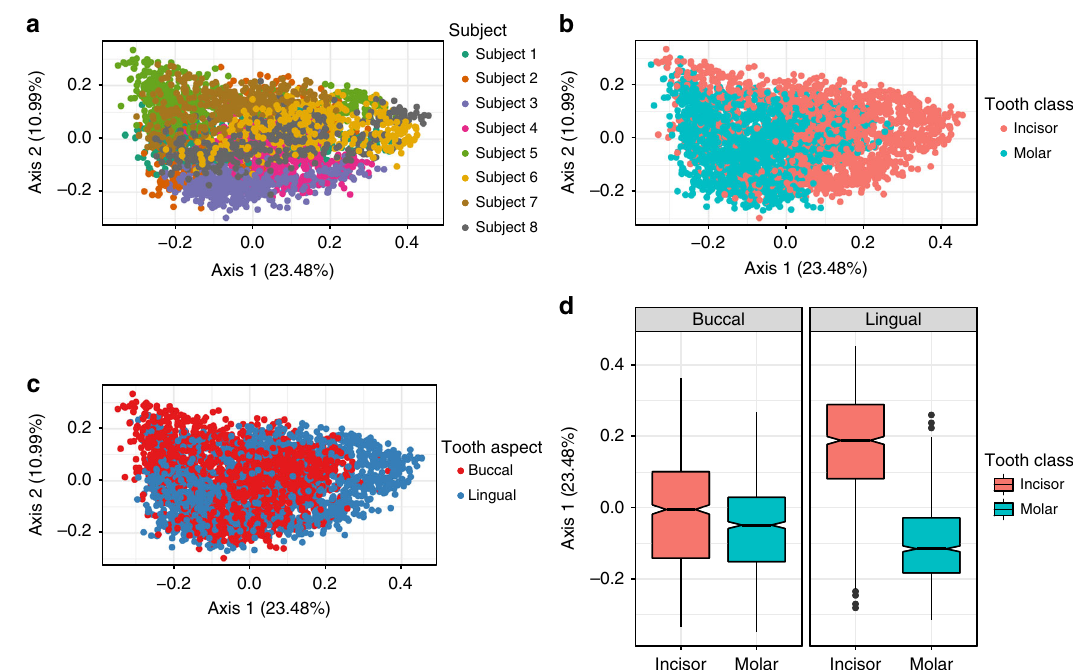
Fig. 1 Subject, tooth class, and tooth aspect explain variation in oral communities. Adonis and PCoA on Bray Curtis dissimilarity (90 taxa, 3393 samples) revealed separation of communities by a subject, b tooth class, and c tooth aspect. d Each boxplot box demarcates the fi rst and third quartiles of the PCoA axis 1 scores, while the horizontal black lines within each box de fi ne the median PCoA axis 1 scores. Boxes are colored according to tooth class (incisor, molar). Boxplots comparing buccal molar communities ( N = 849) to those on the buccal incisors ( N = 849), lingual molars ( N = 846), and lingual incisors ( N = 849) revealed an interaction between tooth class and tooth aspect, highlighting the greater separation of molar and incisor communities at the lingual, as compared to the buccal, tooth